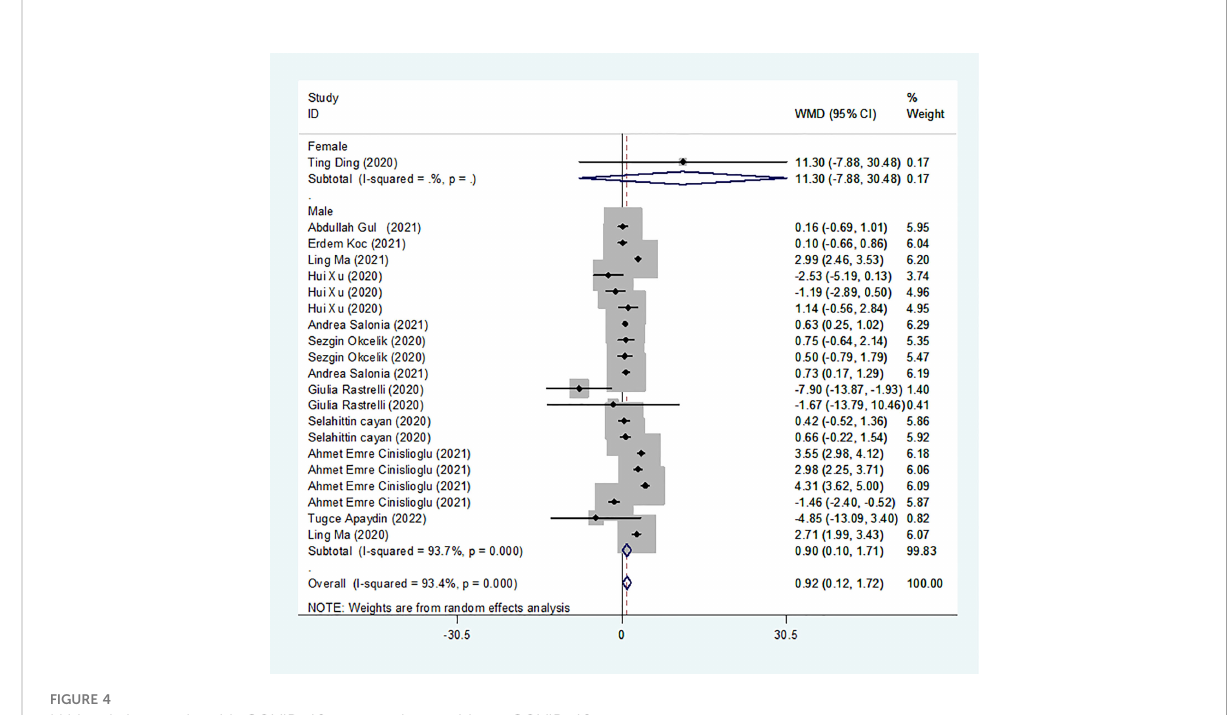
FIGURE 4 LH levels in people with COVID-19 vsersus those without COVID-19.